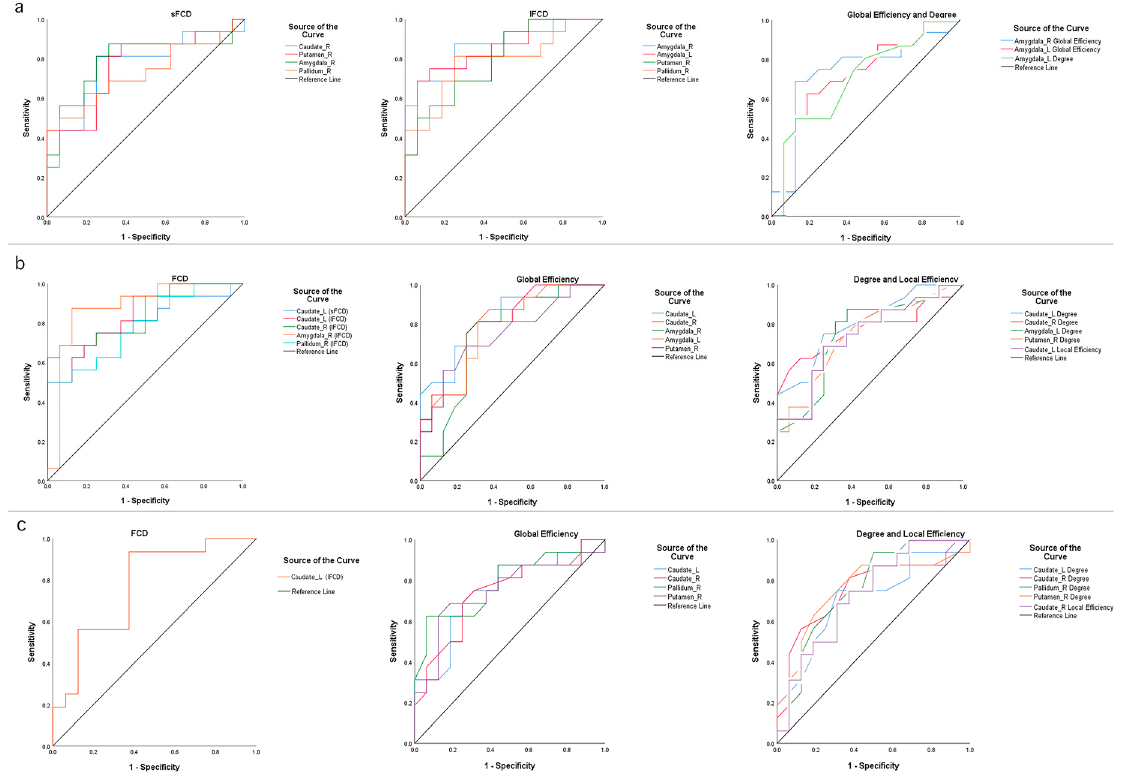
Figure 5. ( a ) Receiver operating characteristic (ROC) curve for FCDs and graph theory indexes in a between-group analysis of patients with MCI and normal controls. ( b ) Receiver operating characteristic (ROC) curve for FCDs and graph theory indices in a between-group analysis of patients with AD and those with MCI. ( c ) Receiver operating characteristic (ROC) curve for FCDs and graph theory indices in a between-group analysis of patients with AD and normal